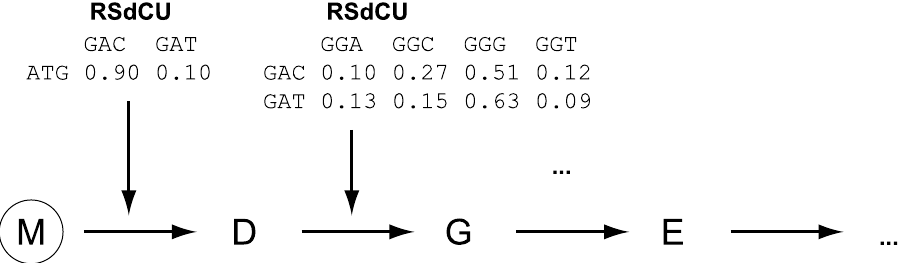
Figure 1. Example of a Markov chain. For a protein sequence starting with M-D-G-E a typical gene sequence will be designed. The RSdCU frequencies are computed based on the set of selected sequences, which could be all genes of a species, the sub-section of the 10% most highly expressed genes of a species, the selection of all genes coding for trans-membrane proteins of a species, or any other user-specified set of genes. All